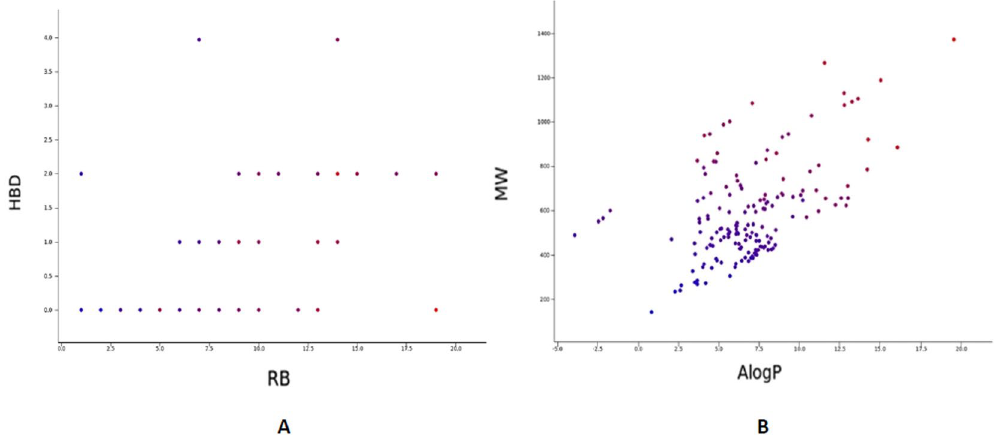
Figure 8. Physicochemical representation of the EE dataset. ( A ) Dispersion of the compounds regarding hydrogen bond donors and rotatable bonds (RB). Color is defined by molecular weight (MW). ( B ) Dispersion of the dataset taking into account logP values and molecular